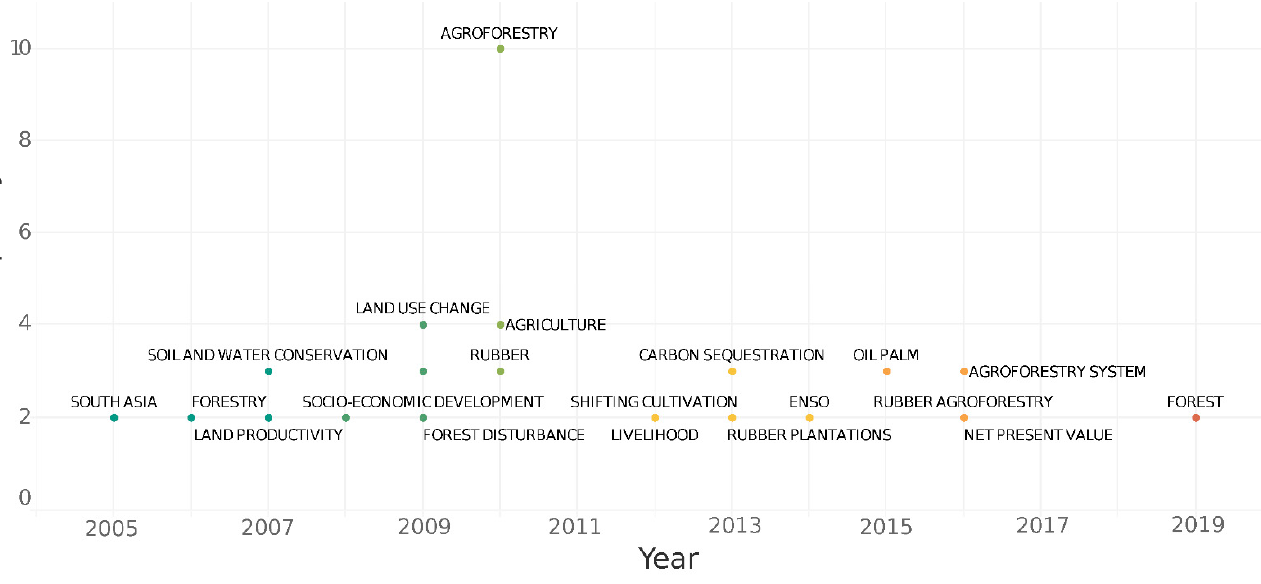
Figure 2. Trends in topics studied from 1991 to 2019 on agroforestry in S. Asia. Y -axis represents the frequency of appearance of the author keywords, and X -axis represents the year.